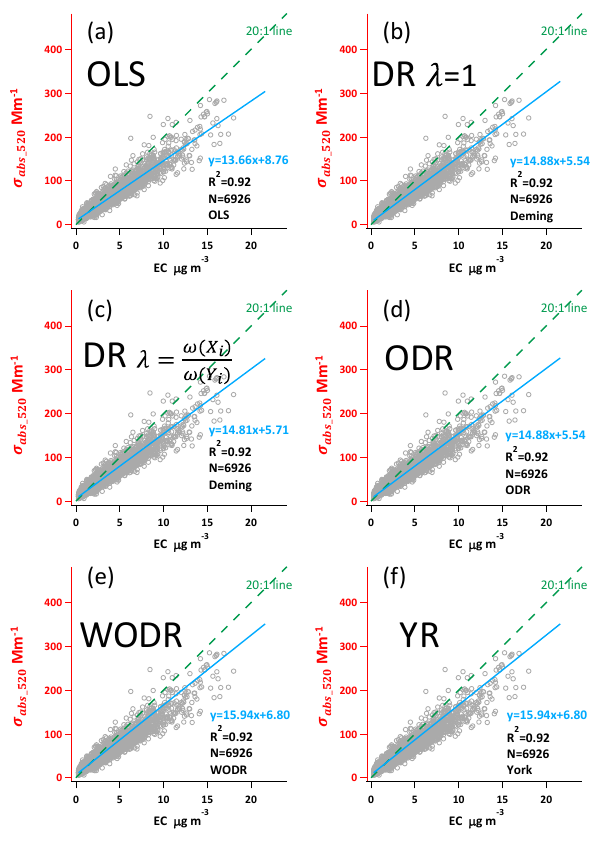
Figure 7. Regression results using ambient σ abs520 and EC data from a suburban site in Guangzhou,